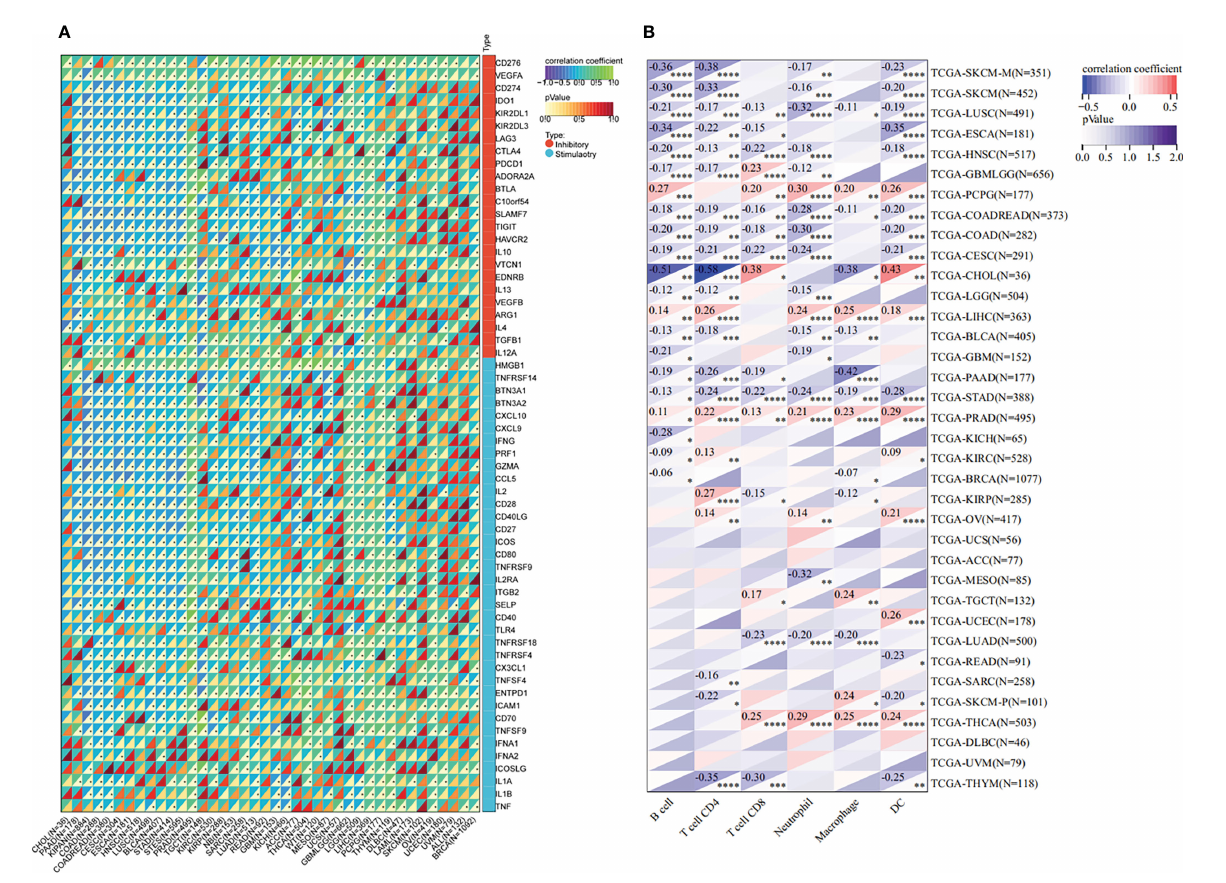
FIGURE 4 Immunological association analyses. (A) The association between ETV4 expression and immune checkpoint genes.The upper triangle of each square represented the magnitude of the p value of the correlation coef fi cient, and the lower triangle represented the magnitude of correlation test. The star dots in the lower triangle represent that difference is signi fi cant. (B) The association between ETV4 expression and immune in fi ltration cells. *p < 0.05; **p < 0.01; ***p < 0.001; ****p <